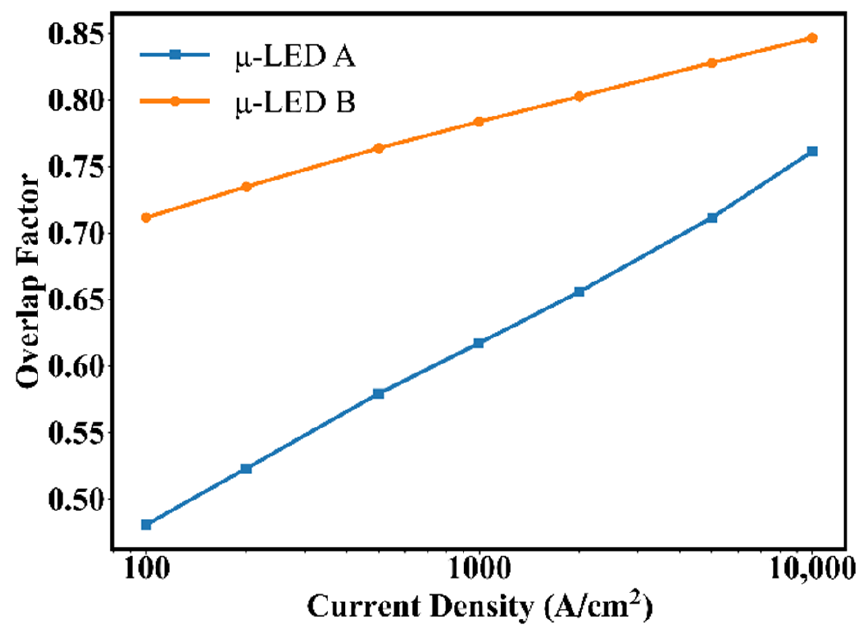
Figure 2. Overlaps of electron-hole wave function vs. current density for μ -LED A and μ -LED B. To understand the internal differences between the two devices, Figure 3 shows the electron and hole concentrations as a function of vertical distance relative to the n- side (relative distance) for the two µ -LEDs at 1 kA/cm 2 . It can be seen that the electron concentration reaches a maximum near the p-side in µ -LED A, but that reaches a maximum near the n-side in µ -LED B. Besides, the hole concentration reaches a maximum at the middle in µ -LED A, but that reaches a maximum near the n-side in µ -LED B. In Figure 3, the peaks of the carrier concentration of the two µ -LEDs are selected and marked. It can be found that the peaks of the carrier concentration of µ -LED A are higher than those of µ -LED B. The above shows that the carrier distribution can be changed by adjusting the structure of QWs, and the cause of which needs to be further